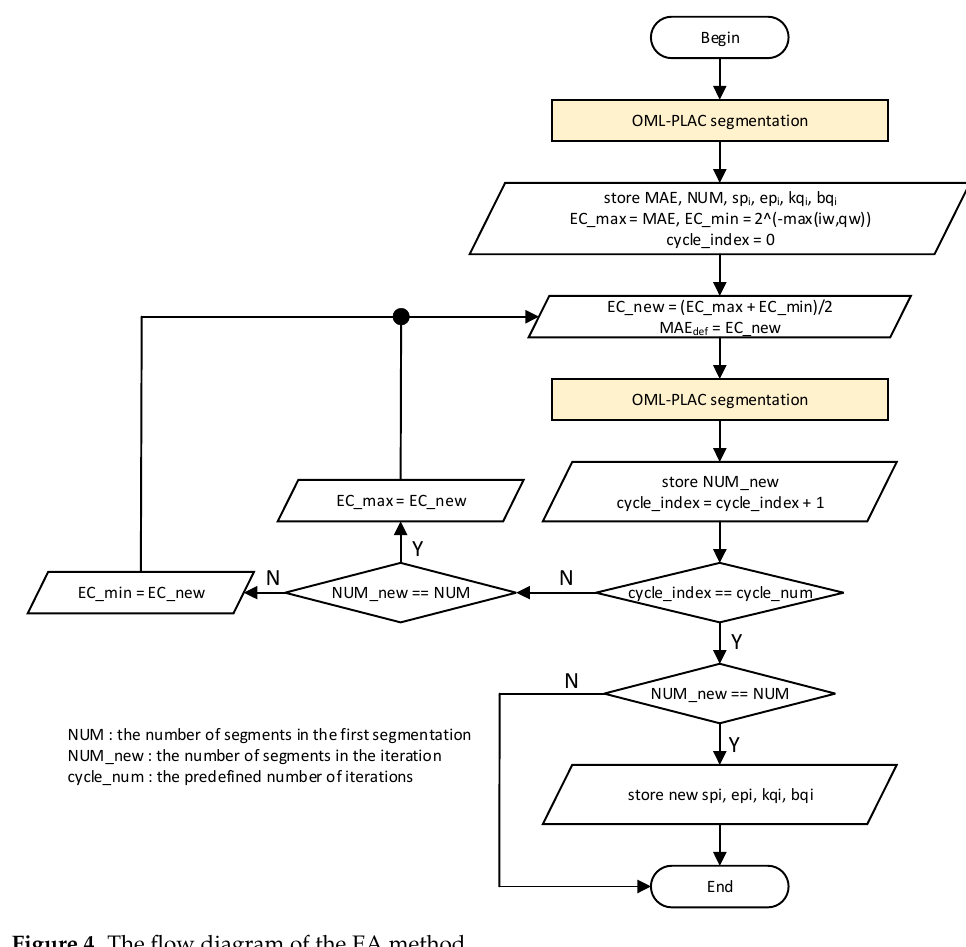
Figure 4. The flow diagram of the EA method .